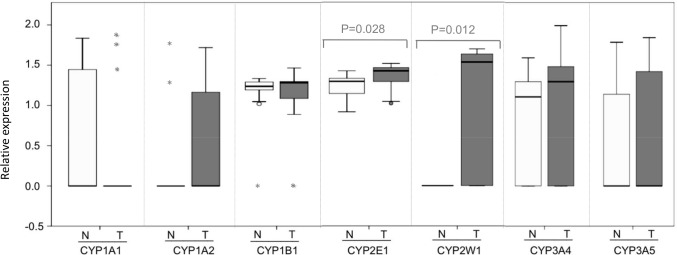
CYP expression levels in tumor and normal adjacent tissues.Box plots demonstrating the CYP-specific/β-actin mRNA ratio for each isoform in all our samples. The bottom and top of the box is the 25th and 75th percentile (the lower and upper quartiles, respectively), and the horizontal line within the box plot diagram represents the median value. The circle indicates an asterisk mark outlier values and extreme cases. The errors bars represent the range of values. Differences between tumor and adjacent normal tissue samples were tested for statistical significance using the Wilcoxon matched-pair test and are indicated with P<0.05.